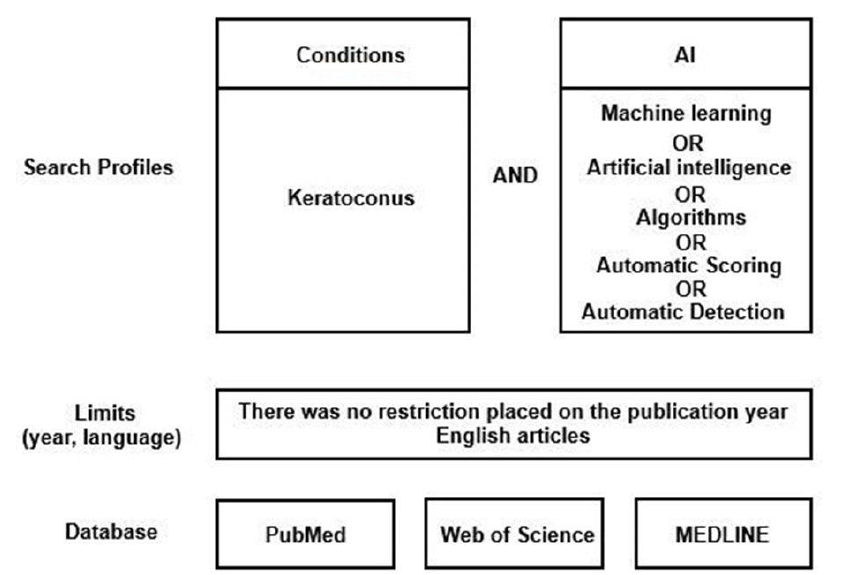
Figure 1. The search strategy used in the present study. PubMed, Web of Science, and MEDLINE were interrogated using search strings pertaining to keratoconus and machine learning. Key words were used by search